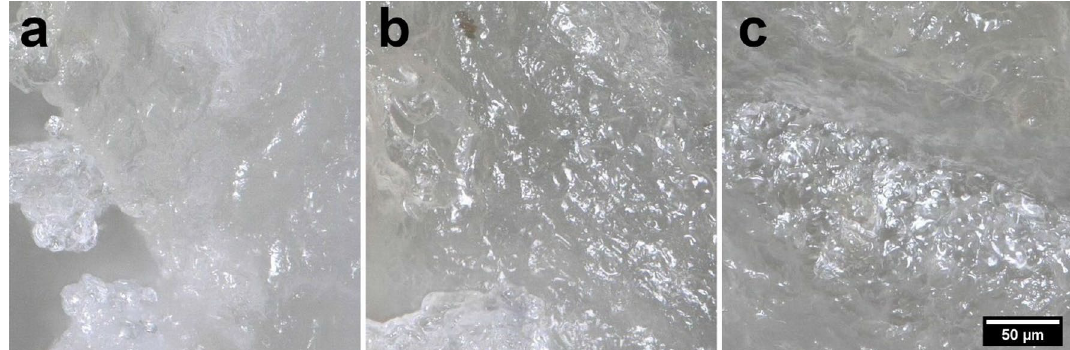
Figure 6. Images of wheat-rye bread samples taken with an optical microscope: ( a ) control; ( b ) 2-min treatment; ( c ) − 10-min